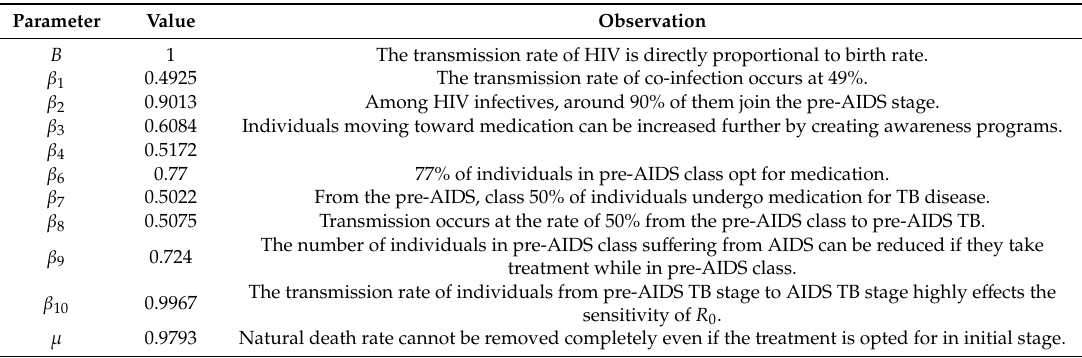
Table 2. E ff ect of Parameters on